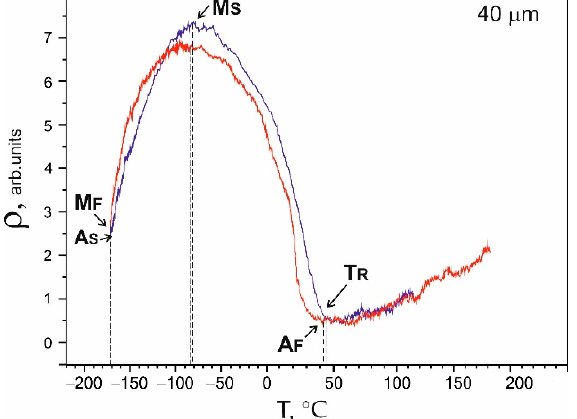
Figure 8. Temperature dependence of electrical resistivity ρ (T) for a 40 µm thick sample.